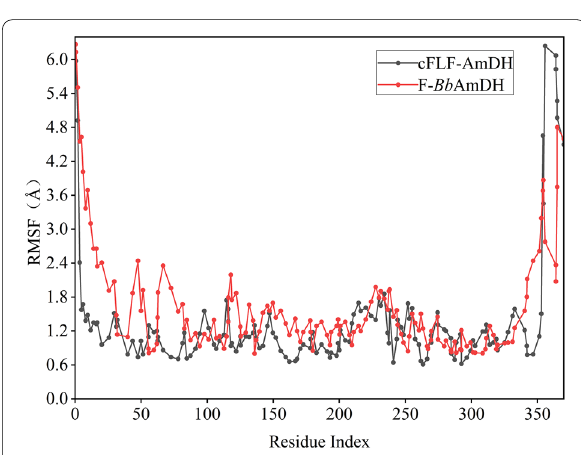
Fig. 4 Comparison and analysis of differences between cFLF-AmDH and F- Bb AmDH based on MD simulation. The RMSF results of cFLF-AmDH (black) and F- Bb AmDH (red) are shown in the line chart. They were calculated for all frames in the trajectory